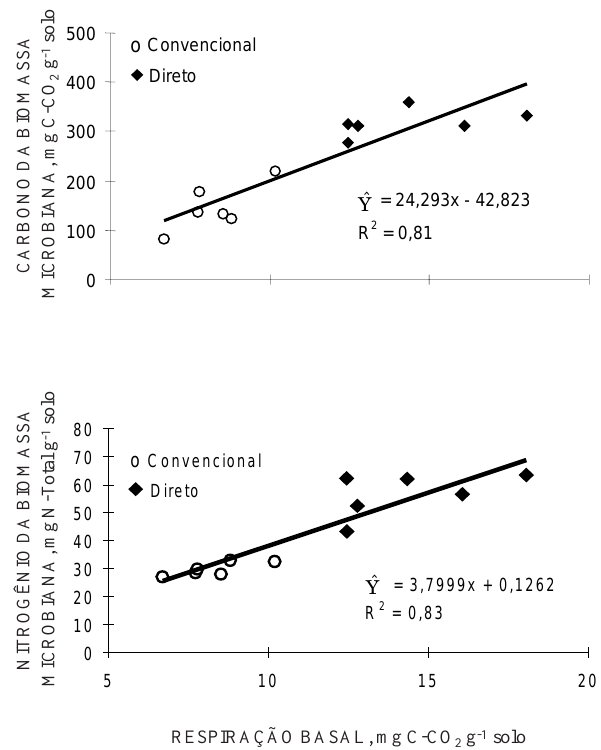
Figura 2. Regressão entre a respiração basal e o carbono da biomassa microbiana e entre o nitrogênio da biomassa microbiana (preparo convencional e plantio direto) para 12 dados a